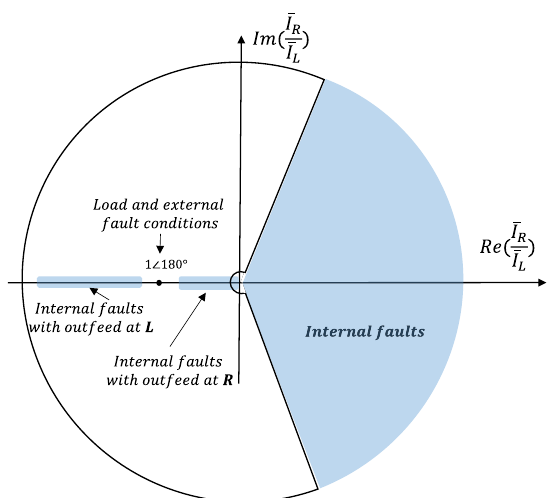
Fig. 6 Alpha plane characteristic